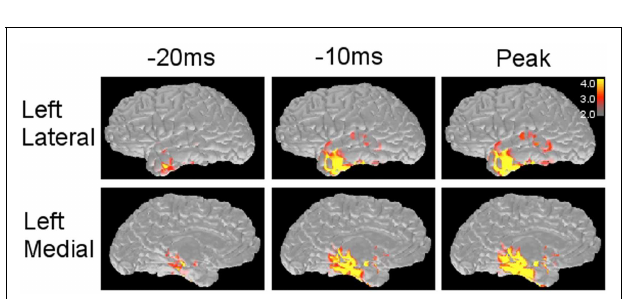
FIGURE 3 | Schematic representation of making a head model .The location correlation of sensors (A) and head (B) is determined by digitization information (dots) and head position indicator in the sensor array (D) .The location information of head (B) and brain (C) is obtained